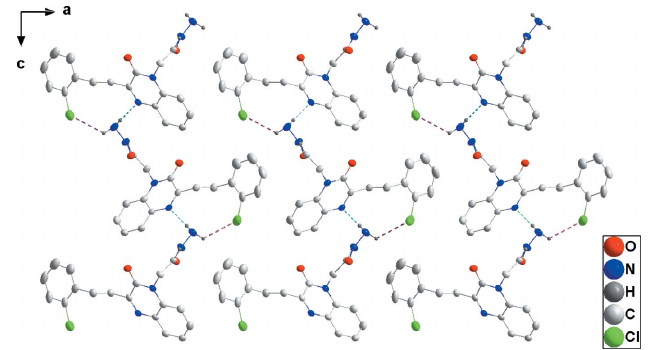
Figure 3 Aview of the zigzag chains formed by N—H (cid:2)(cid:2)(cid:2) N (light-blue dashed lines) and N—H (cid:2)(cid:2)(cid:2) Cl (purple dashed lines) hydrogen bonds projected onto [010].